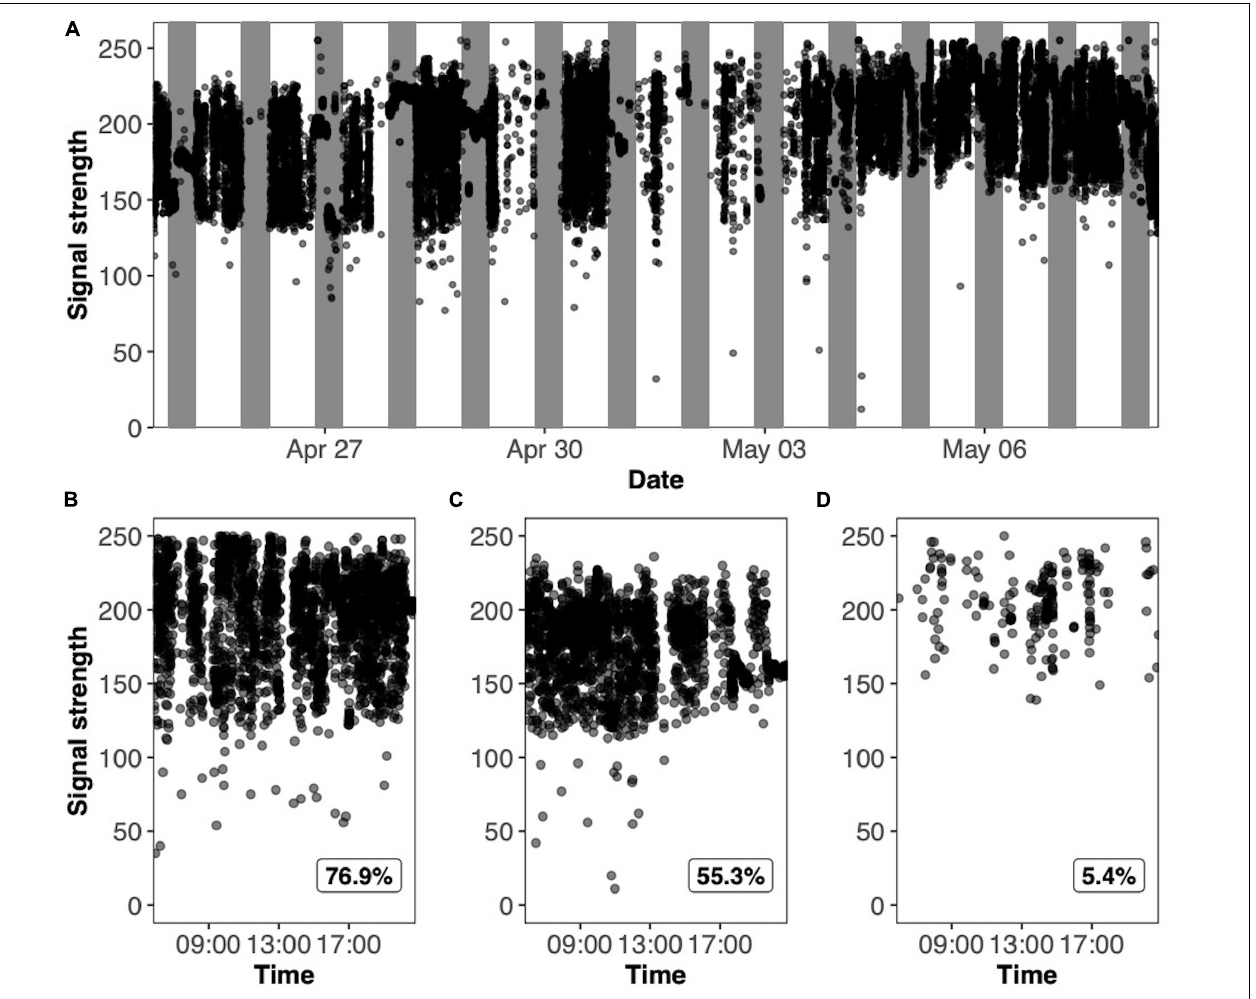
FIGURE 2 | Activity traces of a radio-tagged yellow-rumped warbler ( Setophaga coronata coronata ) in captivity. Each data point represents a detection of the radio-tag by the Lotek receiver. The variation in consecutive detections indicates the movement pattern of the bird. High variation represents a bird that is highly active, while low variation represents no activity (i.e., sleeping or no locomotor movement). Panel (A) shows the activity trace of an individual throughout the duration of spring, where the white segments represent the day sections (lights-on), and the gray segments represent the night sections (lights-off). Panels (B–D) are activity traces demonstrating various signal coverages where the percent signal coverage is outlined in the bottom righthand corner of each